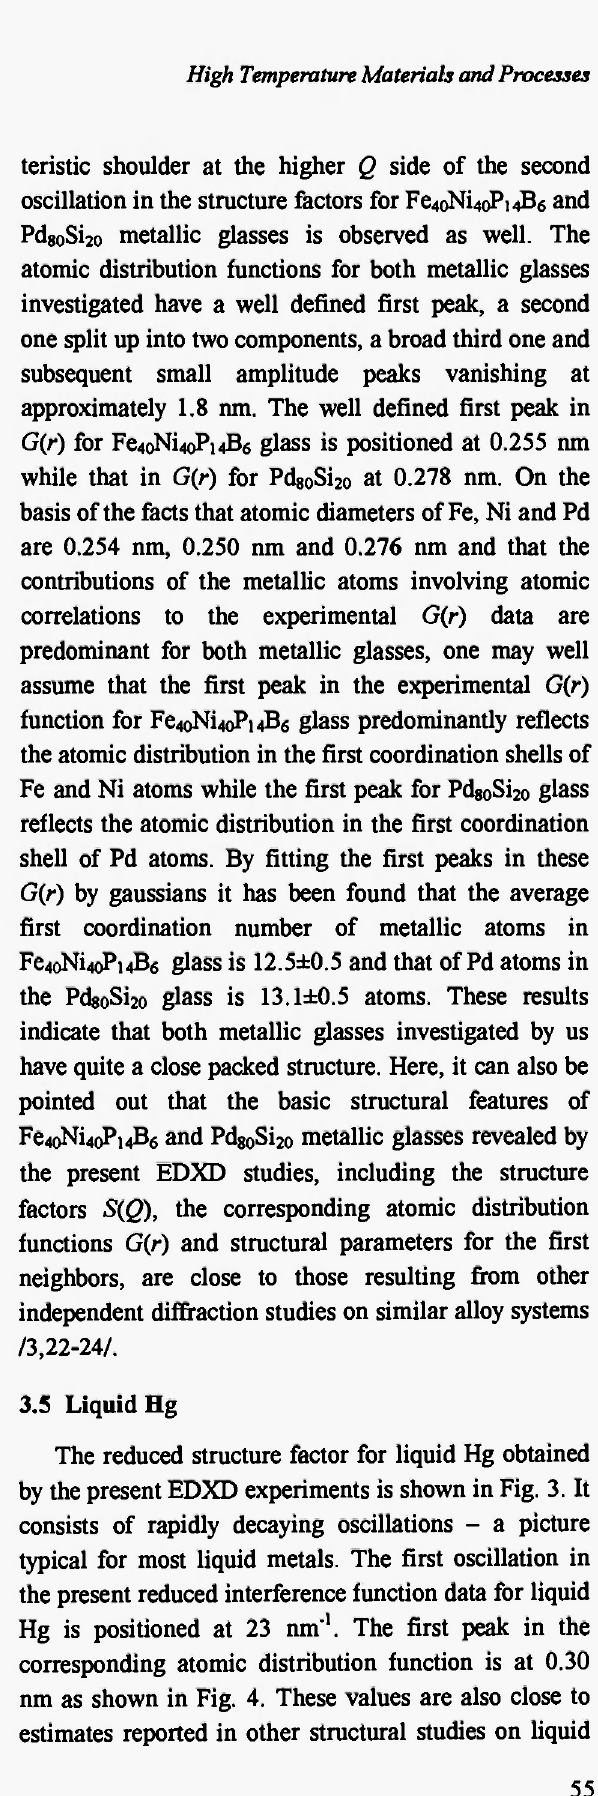
Fig. 6: Segments of the reduced atomic distribution functions G(r), for SrP O glass. Broken line 2 e indicates G(r) data obtained by the Fourier transformation of only a part of the Q(S(Q) -1) less than 0=140 nm" 1 ; full line indicates G(r) data by the Fourier transformation of fullset of Q(S(Qy-l) data up to